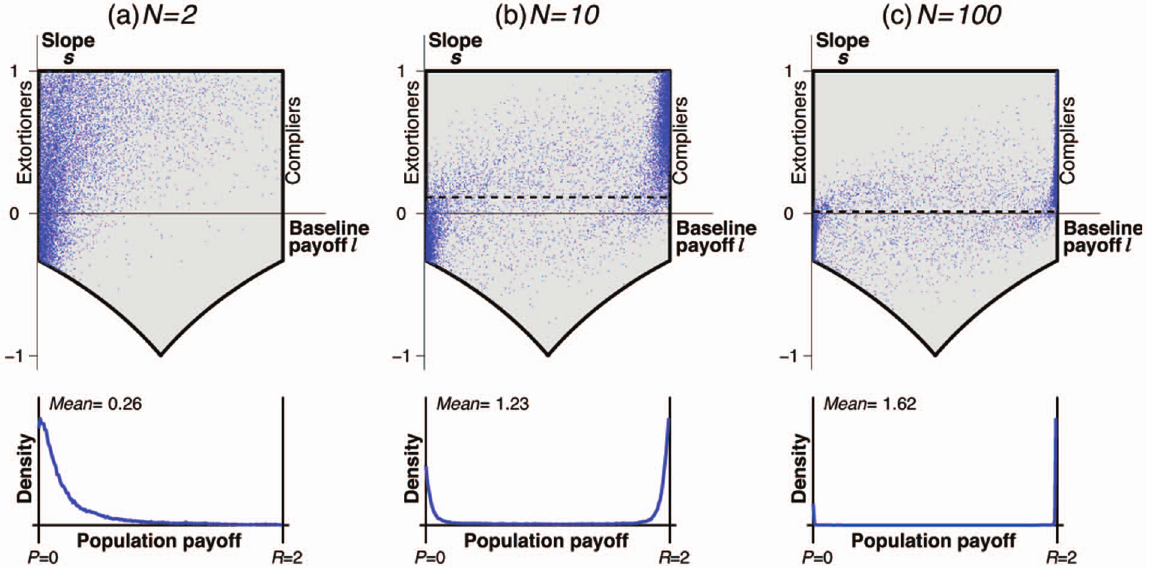
Figure 3. Stochastic dynamics for different population sizes. We consider a homogeneous population of size N [ f 2,10,100 g . Once a mutation occurs, the mutant strategy either takes over the whole population (with probability r ), or goes extinct before the next mutation arises. This leads to a sequence of residents in the state space, which is shown in the upper three graphs (the dashed line corresponds to the threshold 1 = ( N { 1) ). The lower three graphs give the distribution of the resulting payoffs in the population. (a) In the extreme case of N ~ 2 , most players enforce a strategy with baseline payoff l ~ P . In particular, extortion strategies can persist. (b) As population size increases, a bistable situation emerges: the population clusters along the edges with ( l ~ P , s v 1 = ( N { 1)) and ( l ~ R , s w 1 = ( N { 1)) . (c) For large population sizes, this implies that the edge of compliers is (neutrally) stable, whereas the edge of extortioners is unstable. As a consequence, mean payoffs increase with population size. The figure shows simulation runs for 10 5 residents for a prisoner’s dilemma with T ~ 3 , R ~ 2 , P ~ 0 , S ~{ 1 . New mutant strategies are randomly drawn from a Gaussian distribution around the parent strategy ( s ~ 0 : 05 ). The invasion probability r of a mutant is calculated as